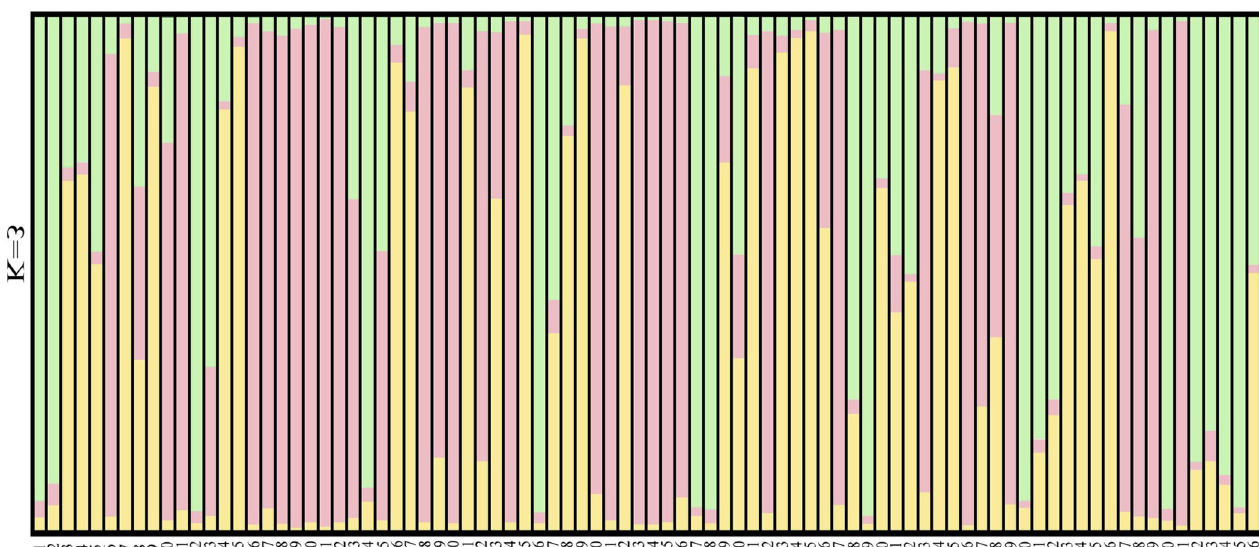
Fig 1. Genetic structure of wild tea tree population at different altitudes in Qianjiazhai Nature Reserve. Different colors indicate three clusters (optimal K = 3). Light green bar represents the first cluster, yellow bar represents the second cluster, pink bar represents the third cluster.